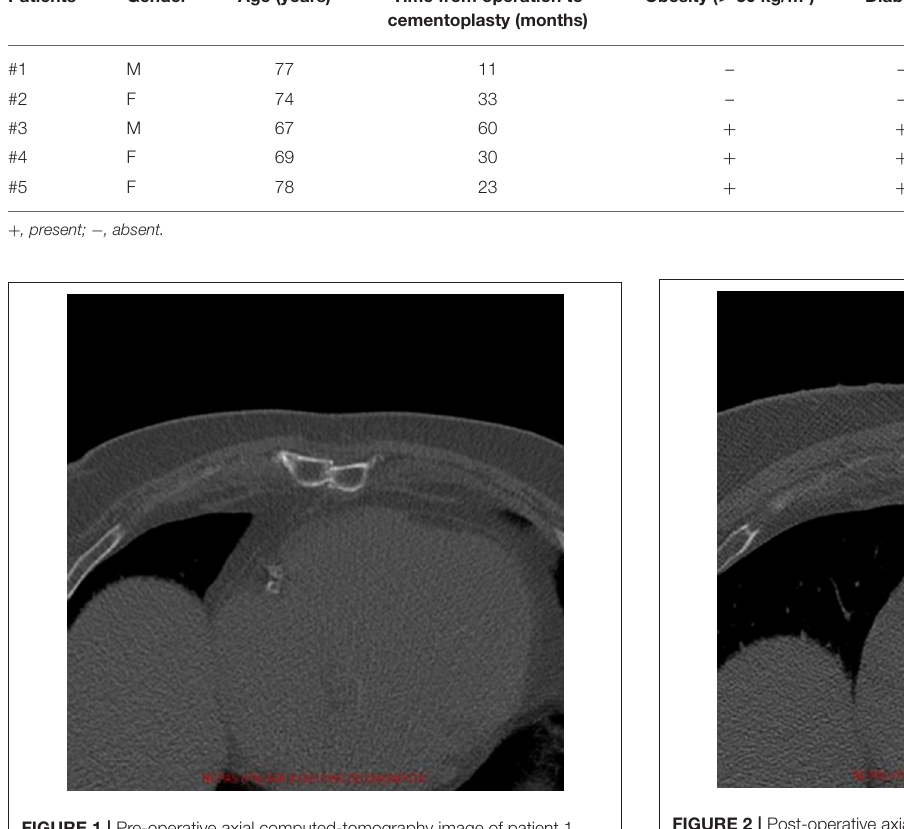
FIGURE 1 | Pre-operative axial computed-tomography image of patient 1. The diagnosis of pseudarthrosis is clear as we can’t see any bone bridges between the two halves.